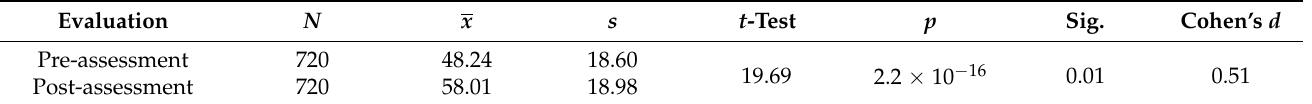
Table 5. Overview of participants’ performance.